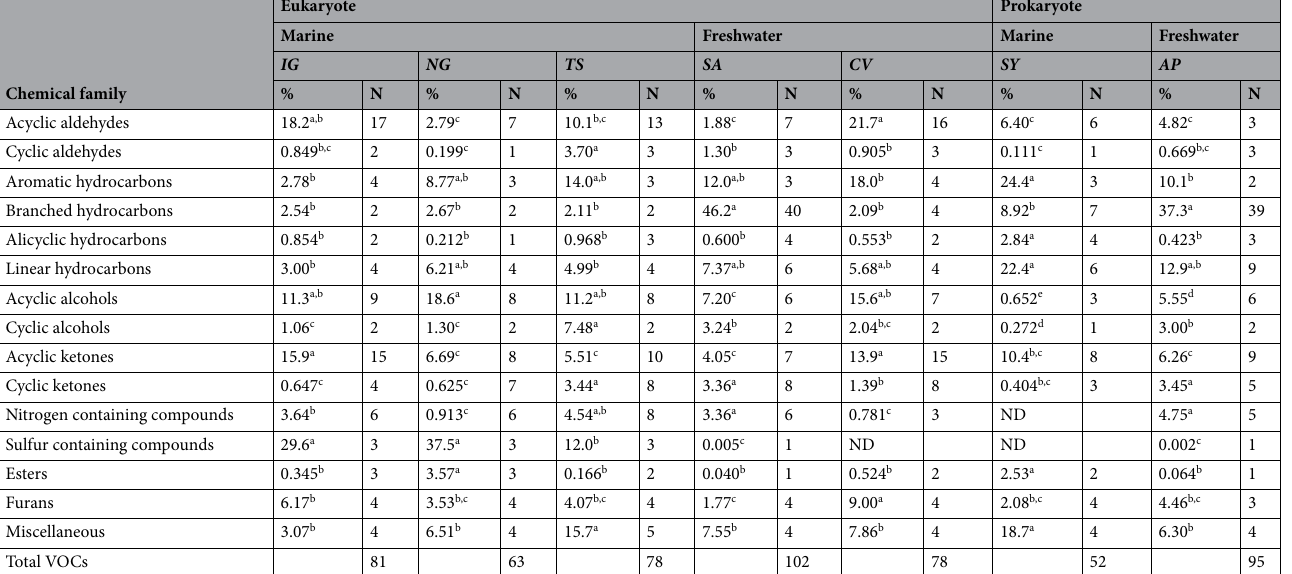
Table 2. Percentage of relative abundance (%) and number of volatile compounds (N) corresponding to chemical families found in selected strains of Isochrysis galbana (IG) , Nannochloropsis gaditana (NG), Tetraselmis sp. (TS), Scenedesmus almeriensis (SA) , Chlorella vulgaris (CV) Synechococcus sp. ( SY ) and Arthrospira platensis ( AP ) classified by domain (eukaryote-microalgae and prokaryote-cyanobacteria) and environment (marine and freshwater). VOCs volatile organic compounds, ND not detected. a,b,c,d,e Means with different superscripts indicate statistically significant ( P ≤ 0.05) differences among